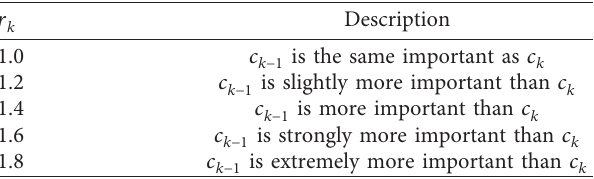
Table 4: Risk evaluation criteria. Table 5: The value of relative importance of